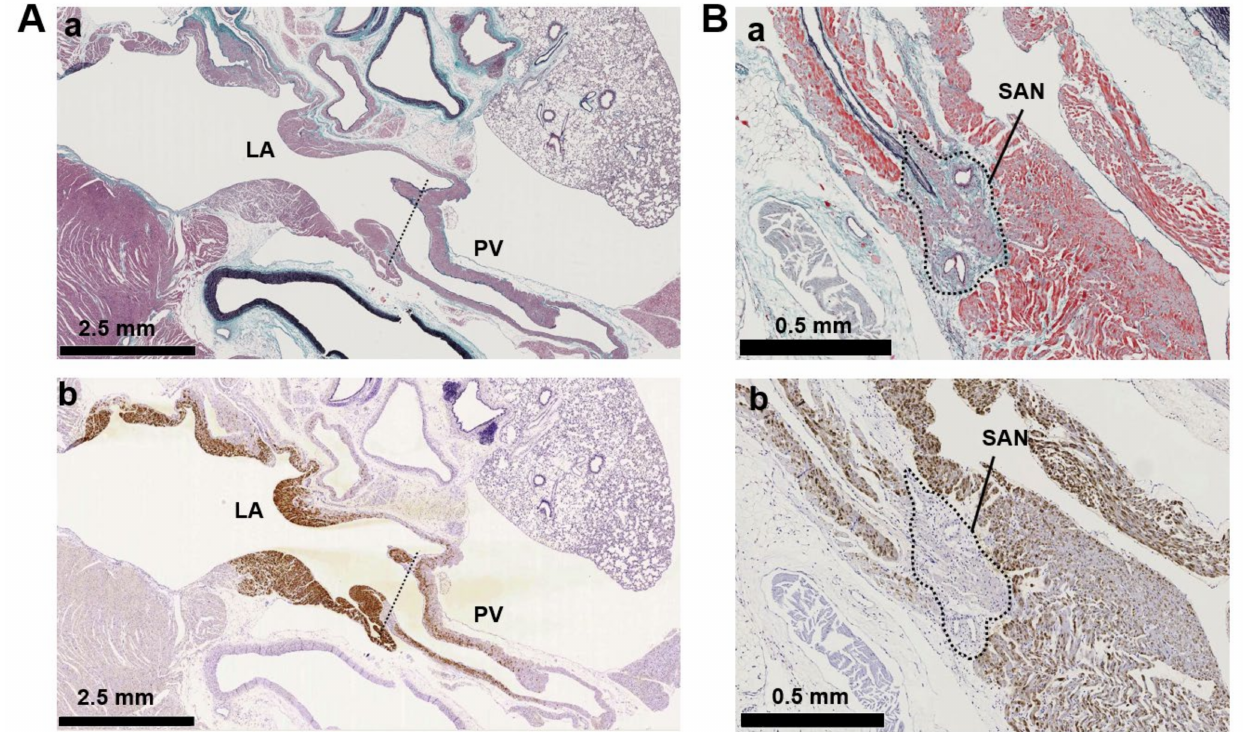
Figure 4. Immunostaining of adenylyl cyclase AC3. (A) Supraventricular regions with Masson’s trichrome staining (Aa) and immunostaining for AC3 (Ab). The ventricular septum is visible beneath the mitral valve on the lower left, a connective tissue-enriched thin structure. The lung is on the upper right. The tentative boundary line between the left atrium (LA) and pulmonary vein (PV) is indicated by a dotted line. (B) Intercaval regions with Masson’s trichrome staining (Ba) and AC3 (Bb) immunostaining. The sinoatrial node (SAN) is defined as a myocardial region surrounded by collagen-enriched connective tissues and contains the SAN artery. The artery is observed as circular cavities. The area indicated by the dotted line is the SAN. The superior vena cava is located immediately above the SAN to the